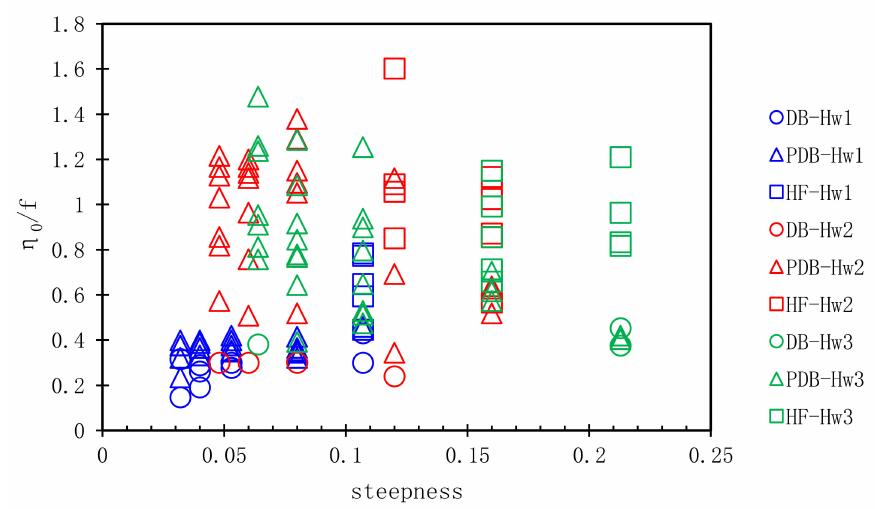
Figure 9. Effect of wave steepness ( ε = H w /L w ) on the nondimensional maximum freeboard ex- ceedance ( η 0 /f , where f is the initial freeboard, 0.05 m) for all the events of the 15 study cases.